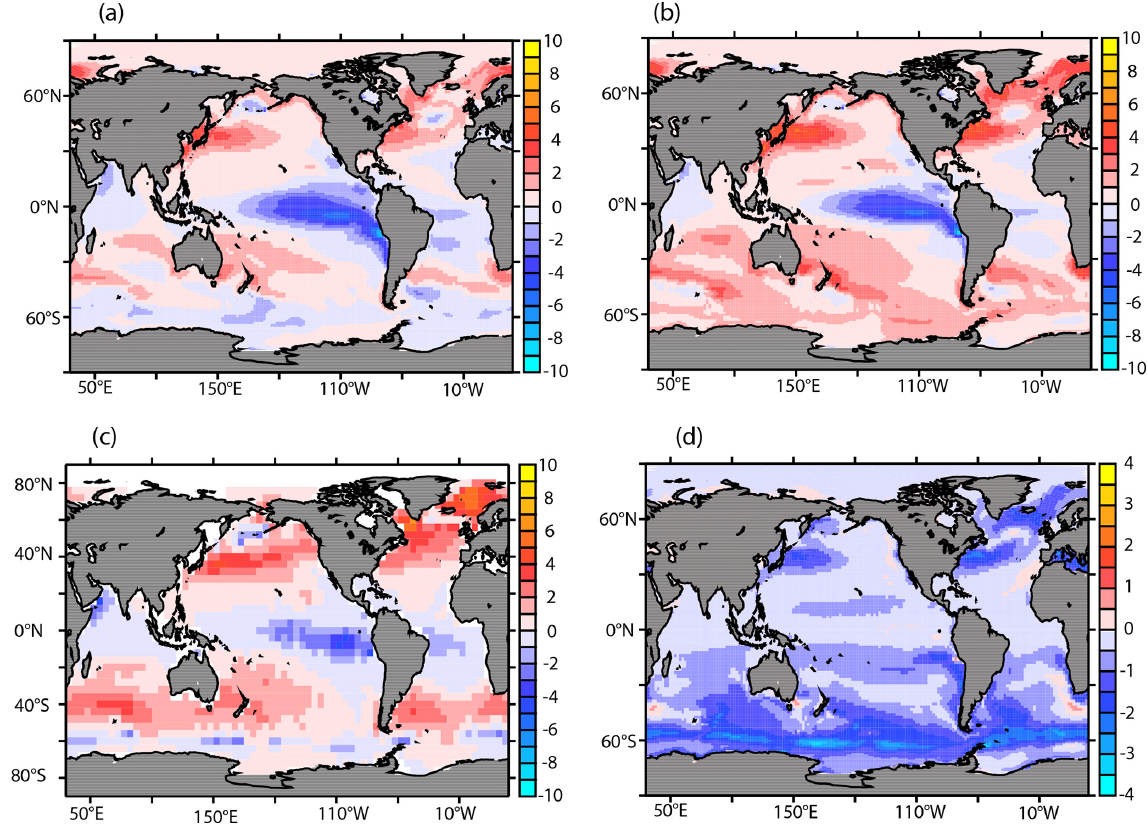
Figure 5. Air–sea CO 2 fluxes for WSTIR averaged over 2000–2006 (a) , Air–sea CO 2 fluxes for CNTRL averaged over 2000–2006 (b) , Air–sea CO 2 fluxes for the climatology of Takahashi et al. (2009) focused on the year 2000 (c) , and the air–sea flux differences between the WSTIR and CNTRL simulations (d) . In all panels, the units are moles Cm − 2 yr − 1 . Positive values indicate carbon uptake by the